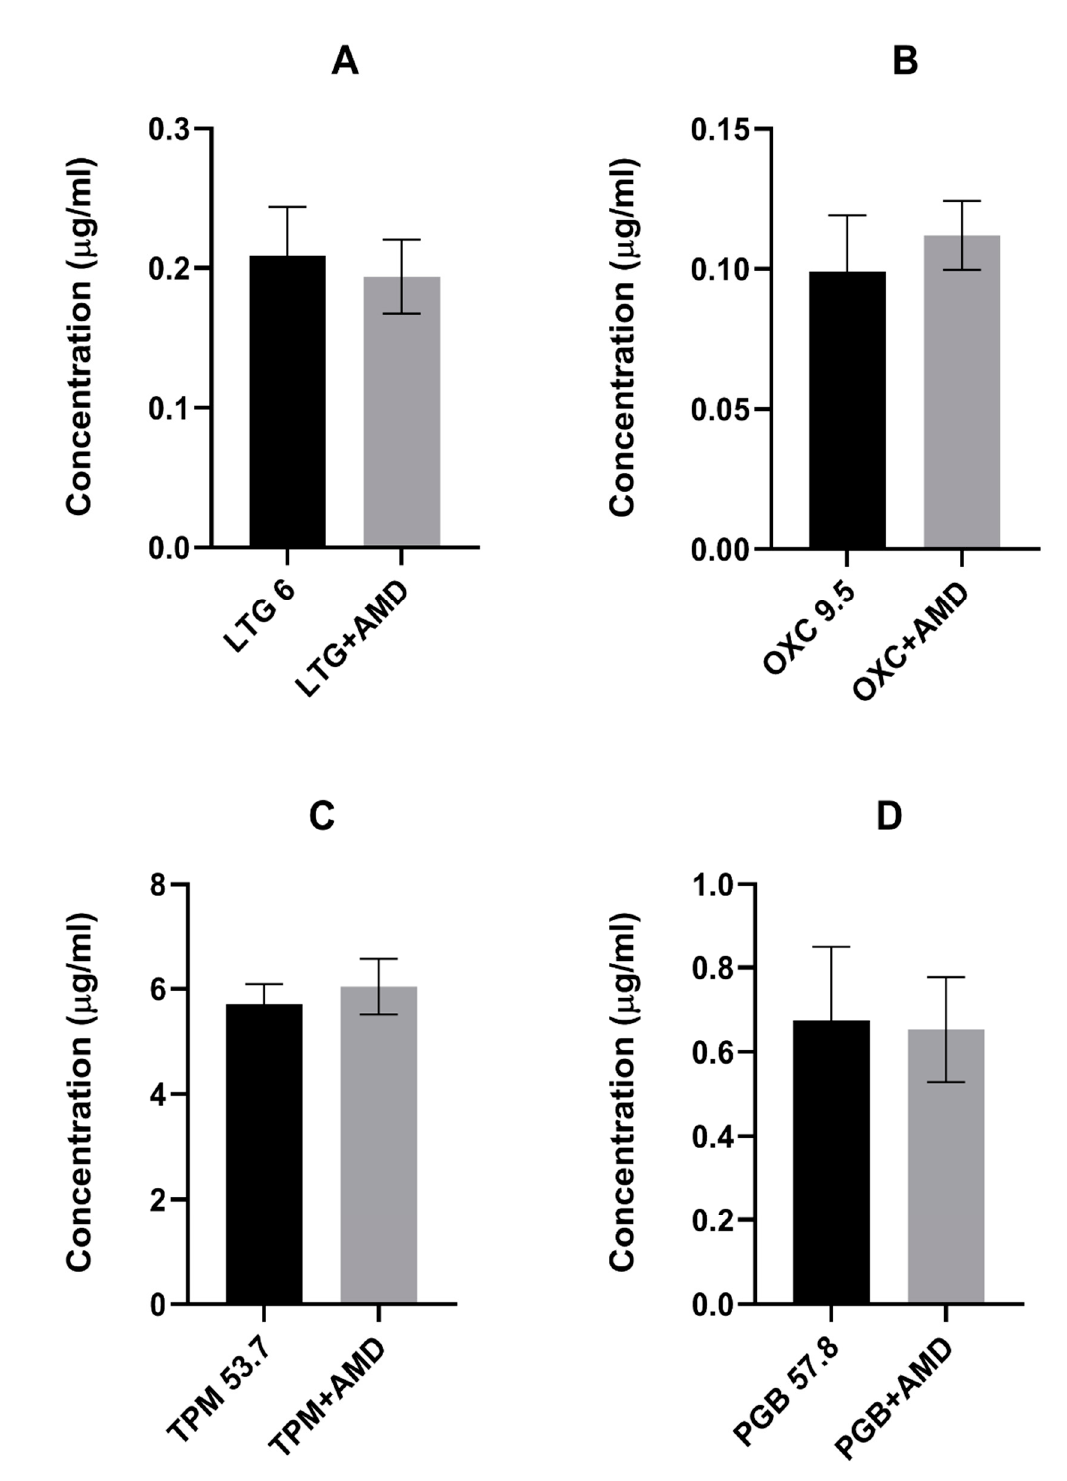
Figure 2. Effects of acute amiodarone on the brain concentrations of: ( A ). lamotrigine, ( B ). oxcarbazepine, ( C ). topiramate and ( D ). pregabalin. Results are presented as the means ± SD (in µ g/mL) of at least eight determinations. Statistical analysis was performed using the unpaired Student’s test. AMD—amiodarone, LTG—lamotrigine, OXC—oxcarbazepine, TPM—topiramate, PGB—pregabalin.